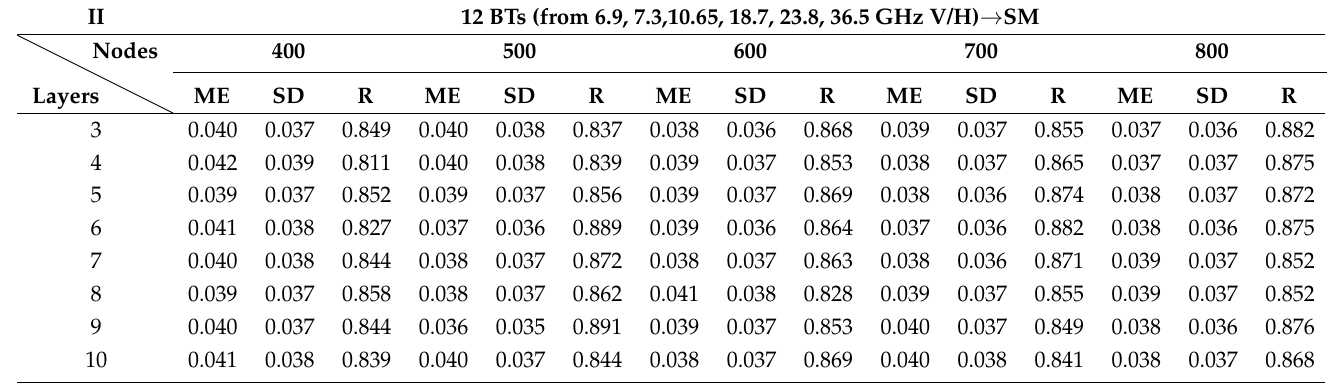
Table 2. Twelve channels are used to retrieve SM (brightness temperature combination of twelve channels).